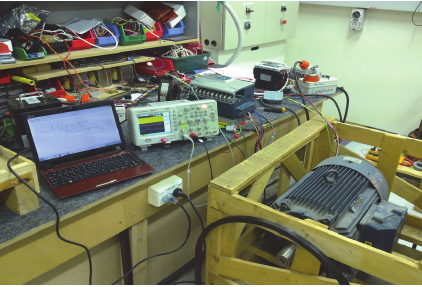
Figure 1: The industrial setup for induction motor experiment.